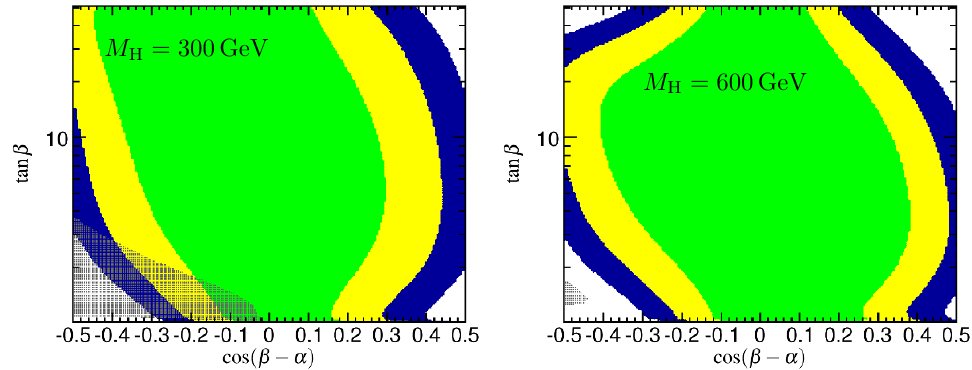
Figure 4 . Direct constraints from LHC Higgs searches on the parameter space for the THDM Type I with M H = 300 GeV (left) and M H = 600 GeV (right). In both cases M h = 125 GeV, Z 4 = Z 5 = 2 and Z 7 = 0 are given in the hybrid basis (cf. ref. [13]). The colours indicate (cid:0) compatibility with the observed Higgs signal at 1 (cid:27) (green), 2 (cid:27) (yellow), and 3 (cid:27) (blue). Exclusion bounds at 95% C.L. from the non-observation of the additional Higgs states are overlaid in gray. The graphics and description are taken from ref. [13].